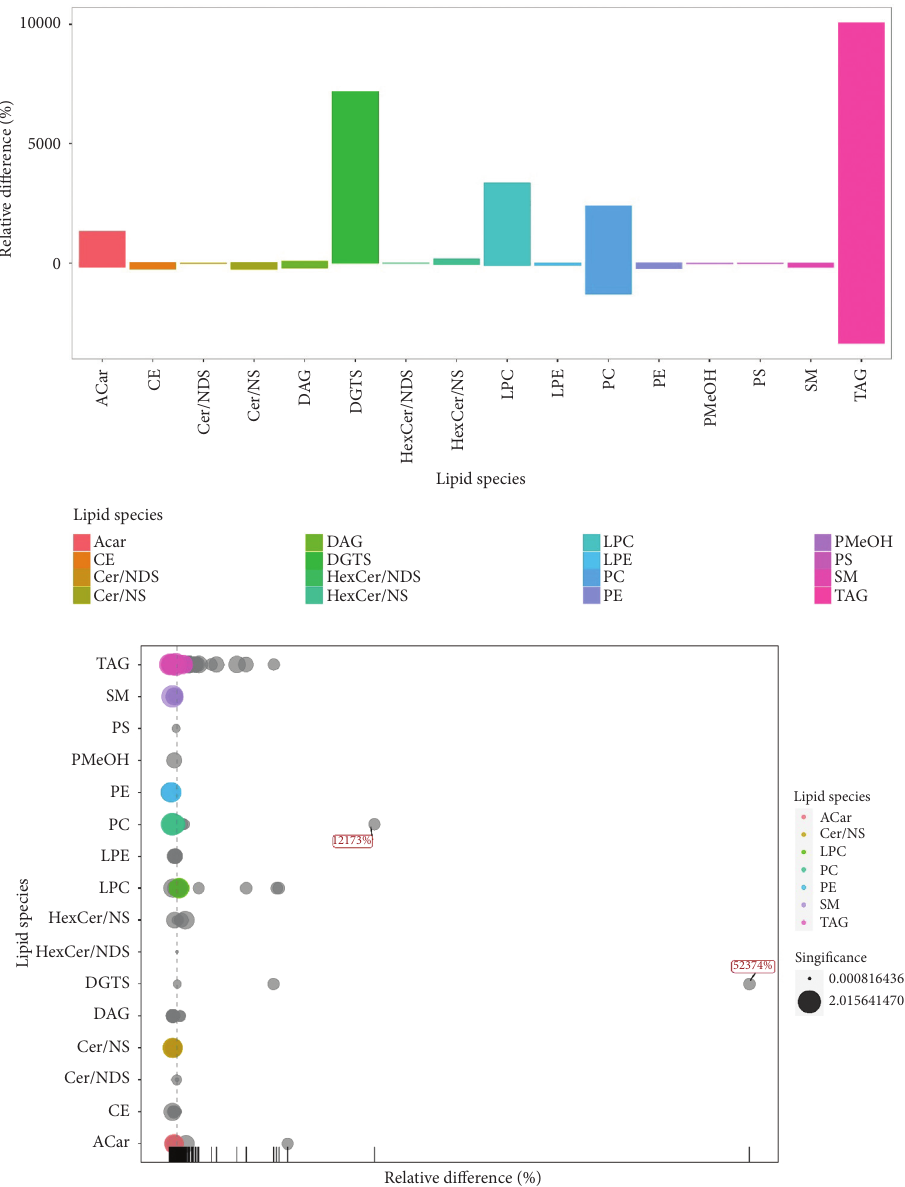
Figure 7: Histogram and bubble plot of lipid group in high-fat feed-ordinary rice group (positive ion